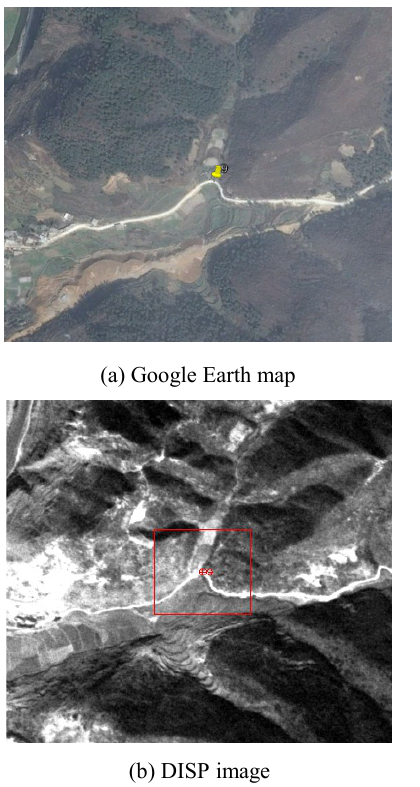
Figure 4. Corresponding to the selection of Google Earth map images